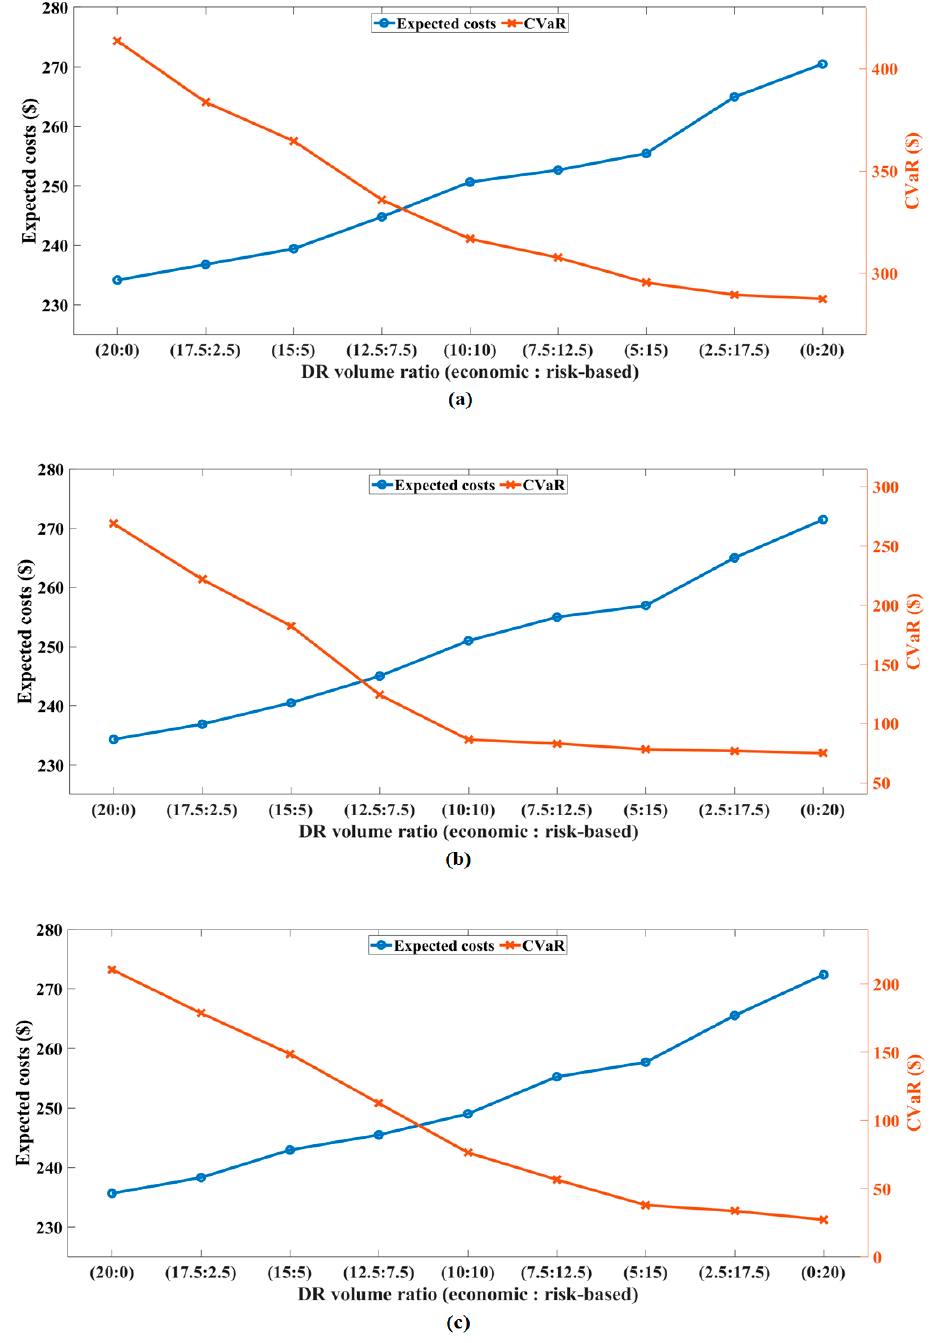
Figure 8. Expected operational costs and CVaR for each β . ( a ) β = 0.1, ( b ) β = 0.5, and ( c ) β = 1.